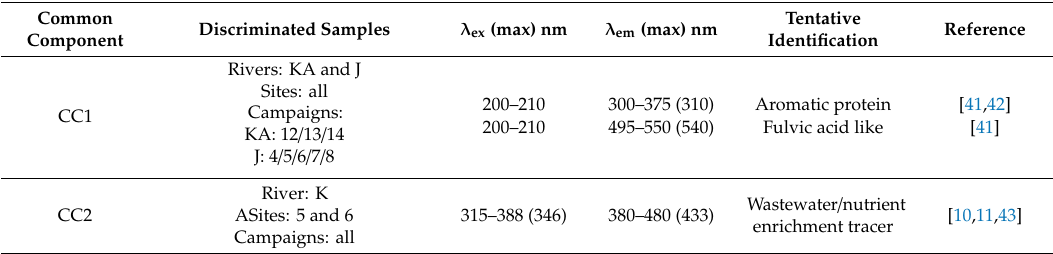
Table 5. Spectral characteristics and tentative identification of ComDim